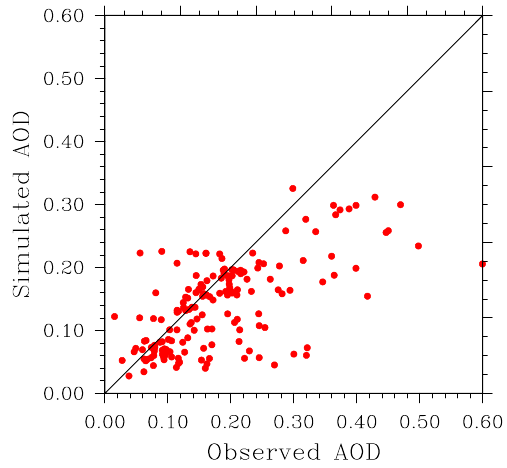
Fig. 9. Time evolution (1970–2009) of mid-troposphere ozone (springtime mean) from Cooper et al. (2010). Observations are in red, CAM-chem results are in black (solid line) and G-PUCCINI results are in black (solid squares).